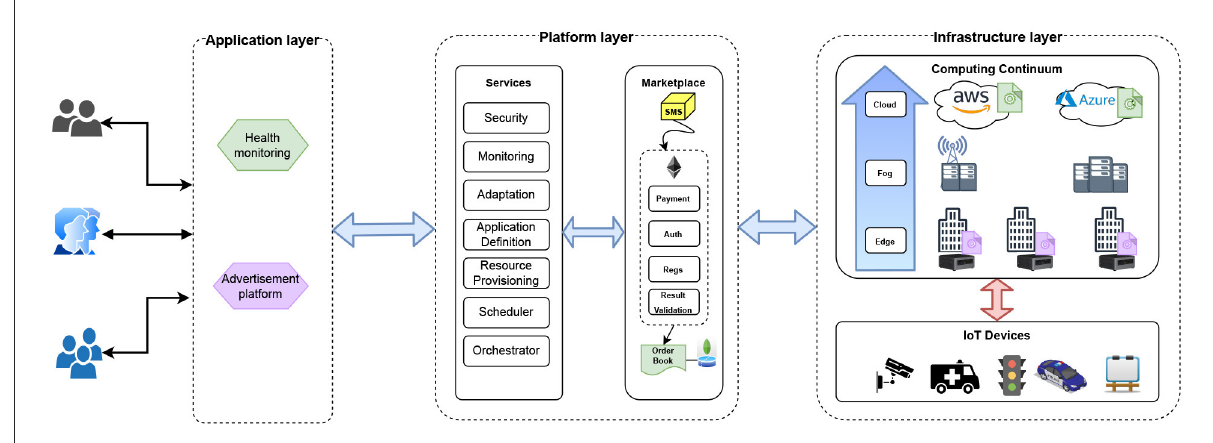
FIGURE4 Proposing architectural framework for managing the Big Data pipelines in Smart